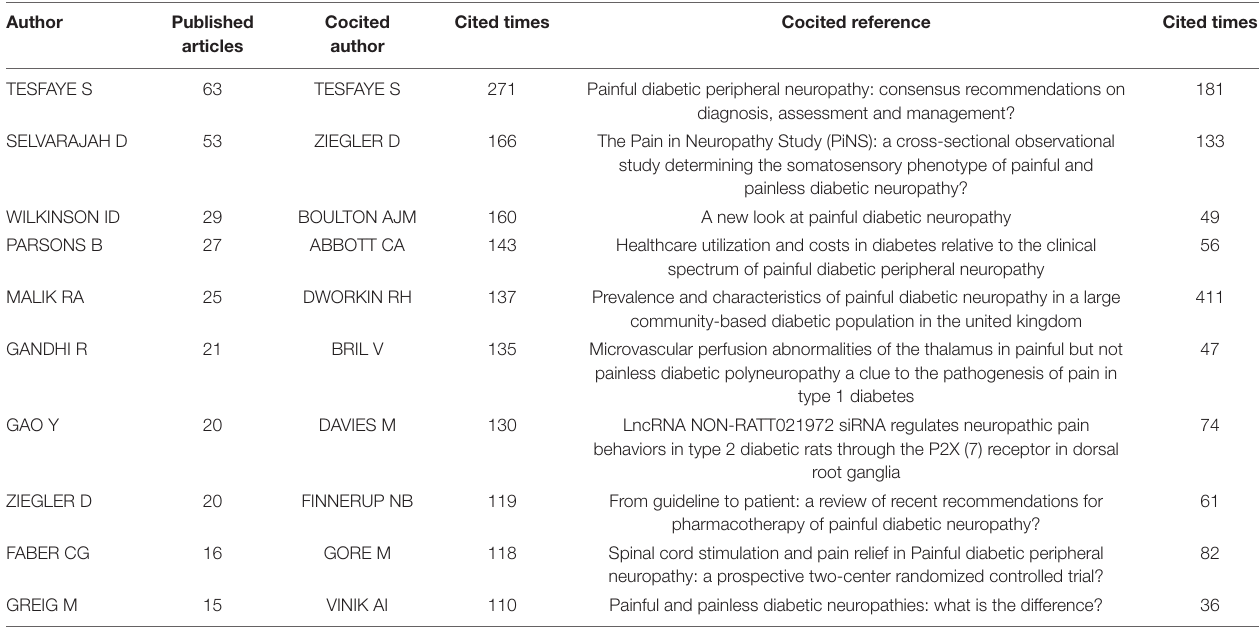
FIGURE 8 | The amounts of papers, citations, citations per paper, open access papers, and H-index of the top 10 institutions. TABLE 2 | The top 10 authors, co-cited authors, and co-cited references on DPNP